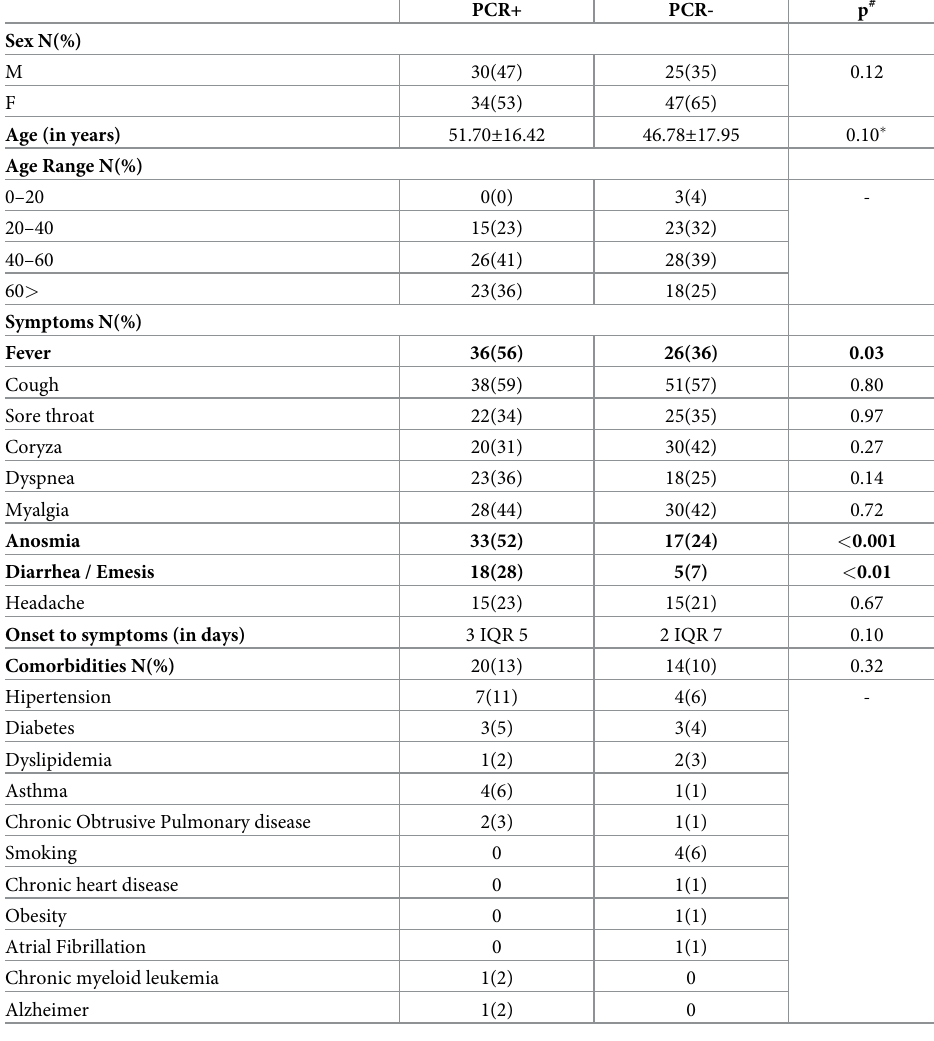
# p-values for all other signs were obtained from Mann-Whitney rank test for independent samples � p-values for means comparisons were obtained from the t-student test for independent